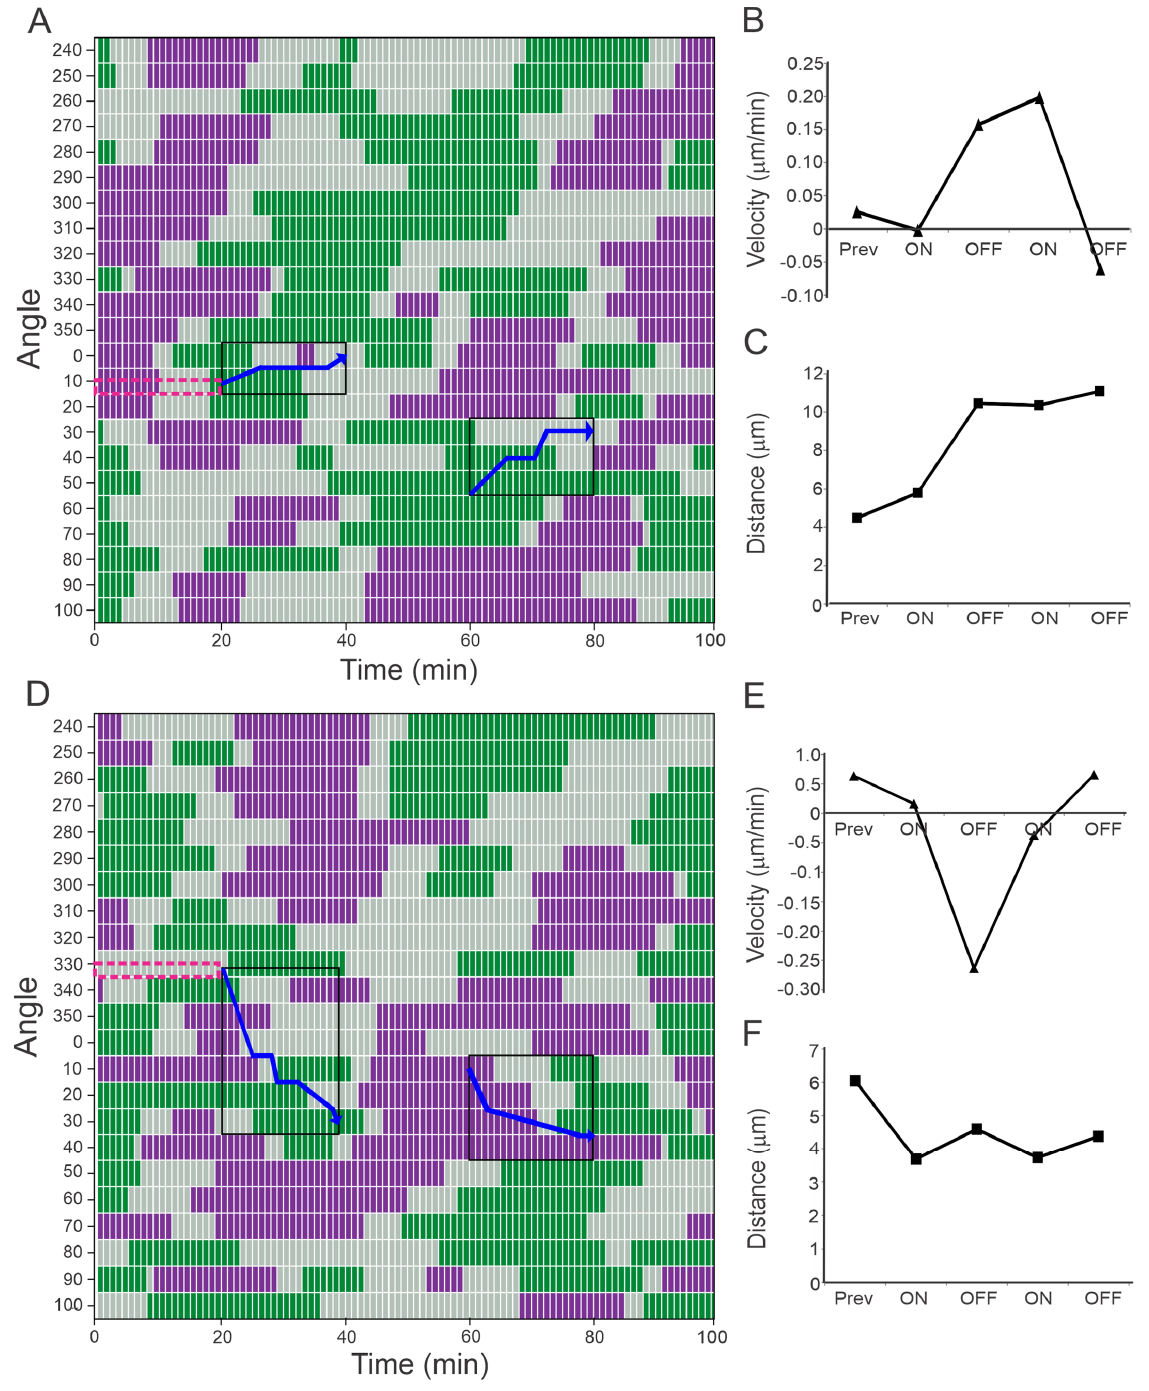
Figure 4. Similar to Figure 3, for cells #3 and #4 ( A – C ) and ( D –F), respectively.